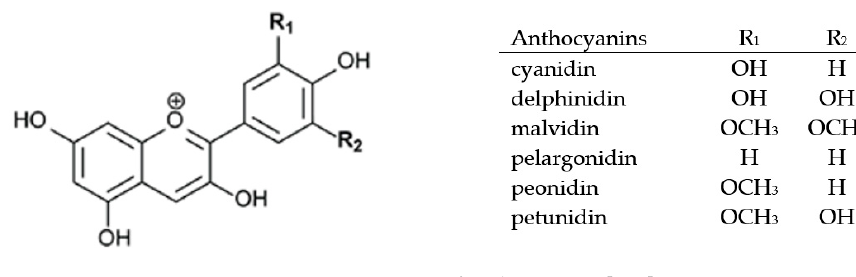
Figure 10. Structure of anthocyanins [158].